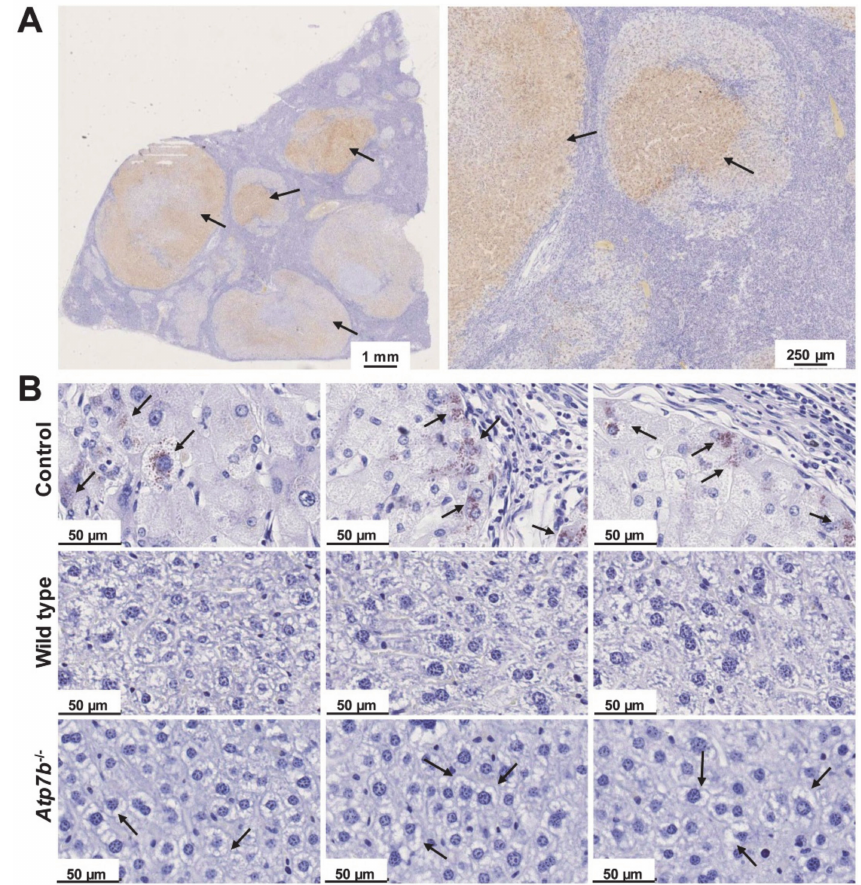
Figure 3. Rhodanine copper stain. ( A ) Rhodanine is a chelating agent forming red-brownish complexes with proteinaceous copper deposits (marked by arrows). Shown is a representative stain of a liver section of a Wilson disease patient at di ff erent magnifications. ( B ) However, the classical rhodanine stain yielded false negative results in Atp7b – / – mice, showing that the diagnostic value of this histochemical staining is limited. In microphotographs, only the microvescular steatosis in Atp7b – / – liver sections (marked by arrows) was